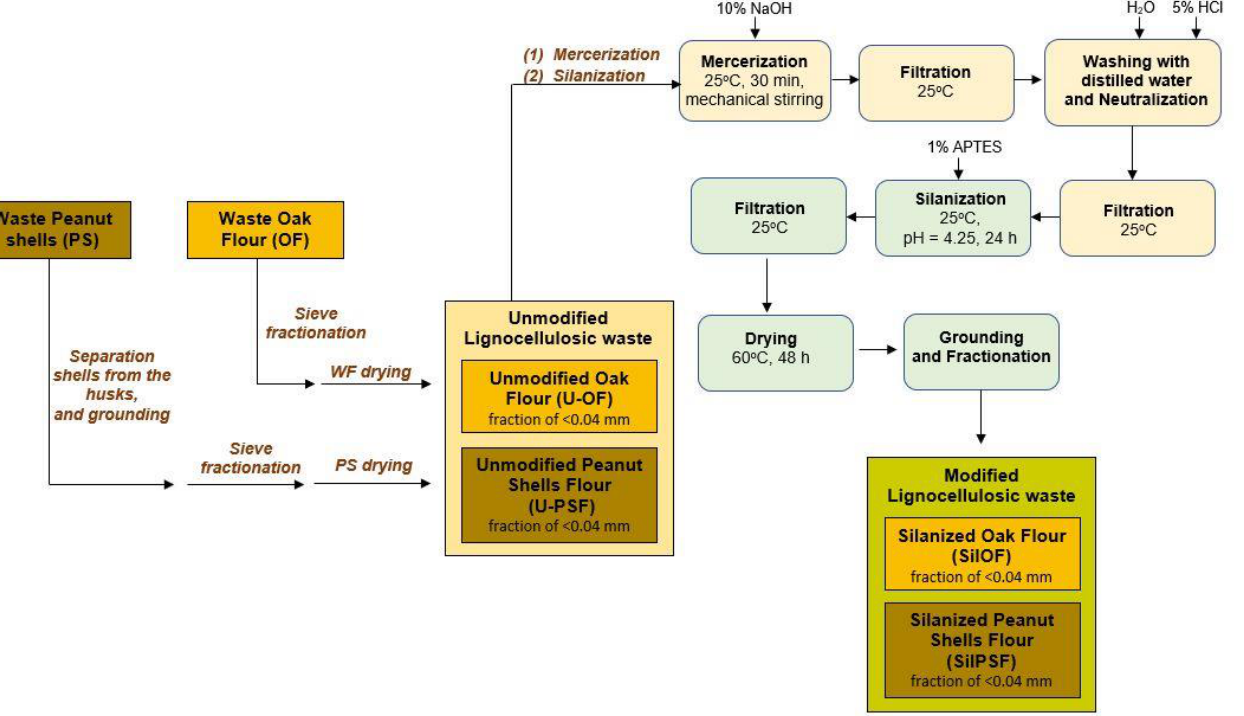
Figure 1. Block diagram of the chemical modification process of lignocellulosic